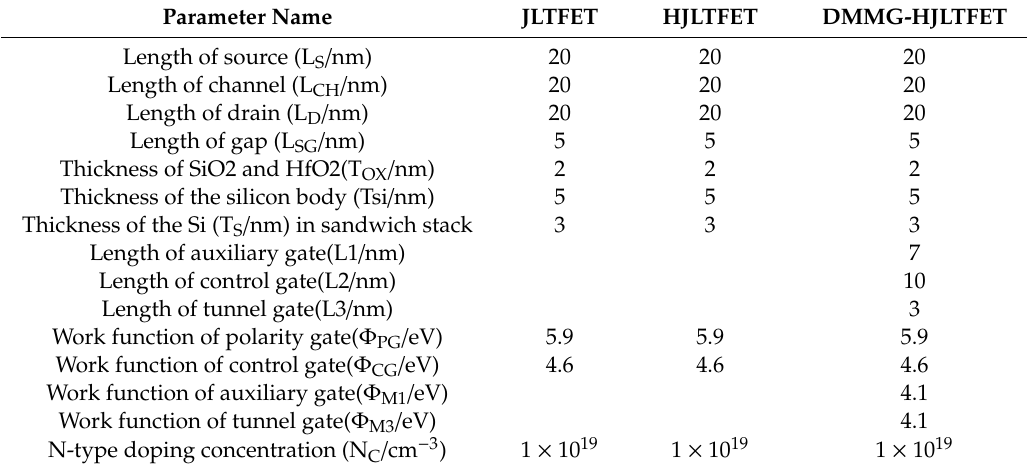
Figure 1. Cross-sectional view of ( a ) JLTFET; ( b ) HJLTFET; ( c ) DMMG-HJLTFET. Table 1. The fundamental geometrical parameters of the different devices.